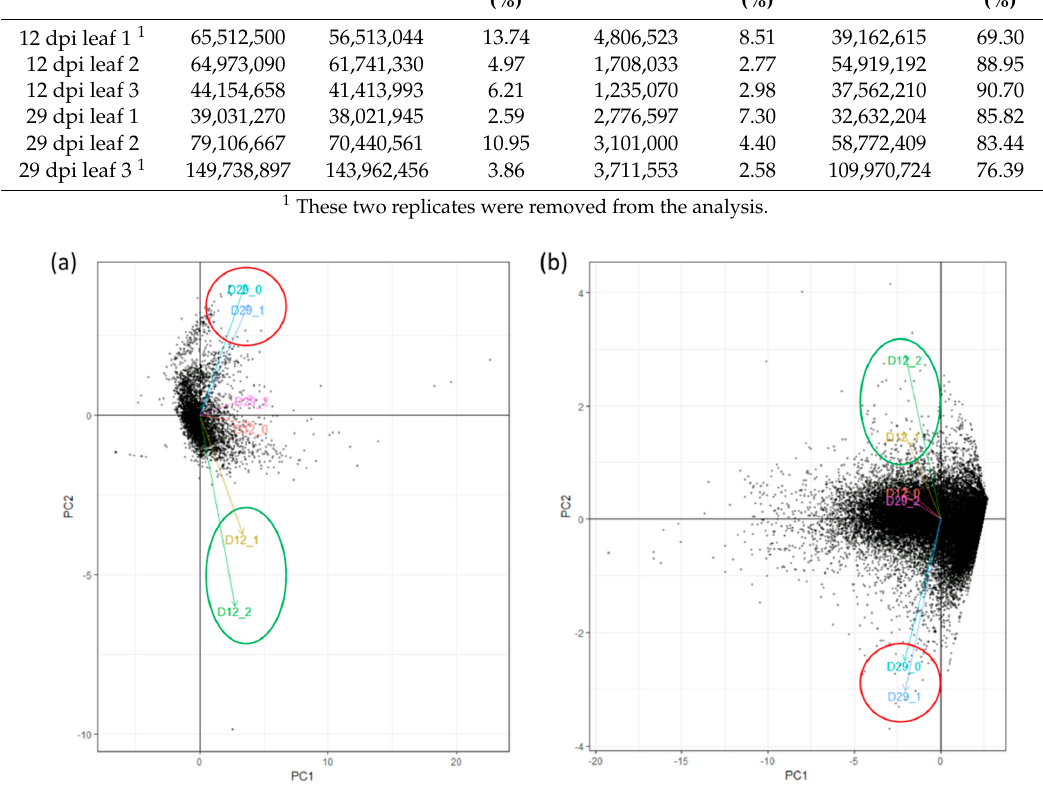
Figure 1. The principle component analysis (PCA) performed with the CummeRbund workflow on differentially expressed genes for ( a ) Xanthomonas fragariae and ( b ) Fragaria × ananassa . Three leaf replicates at 12 days post inoculation (dpi) (D12_0, D12_1, D12_2) and three leaf replicate at 29 dpi (D29_0, D29_1, D29_2) were analyzed with principle component for both bacteria and plant and the arrows represent the most-varying direction of the data.